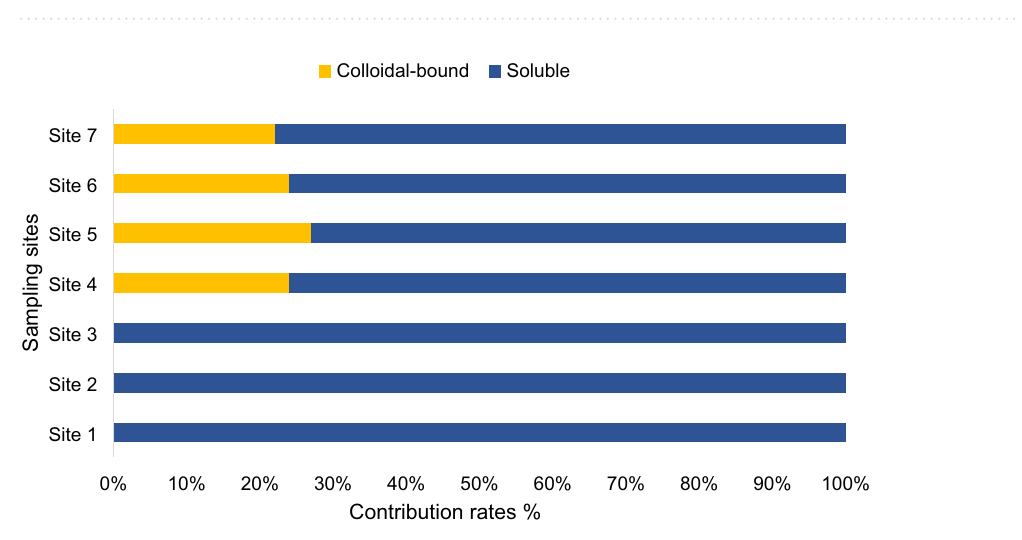
Figure 5. ( a ) Monthly distribution of total rainfall and ( b ) river discharge.